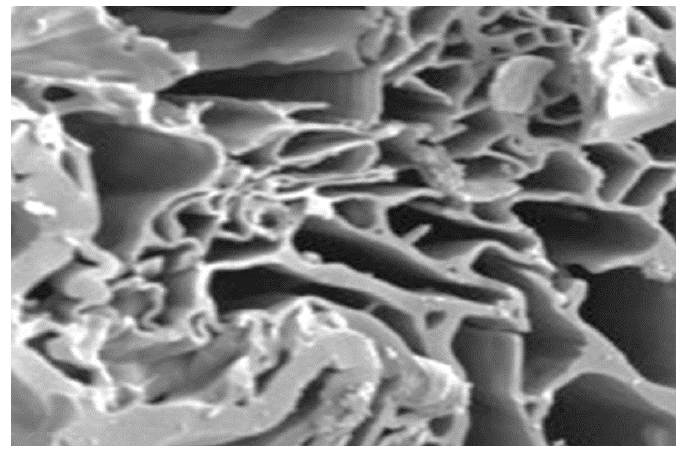
Figure 1. SEM image of the studied rice husk biochar.